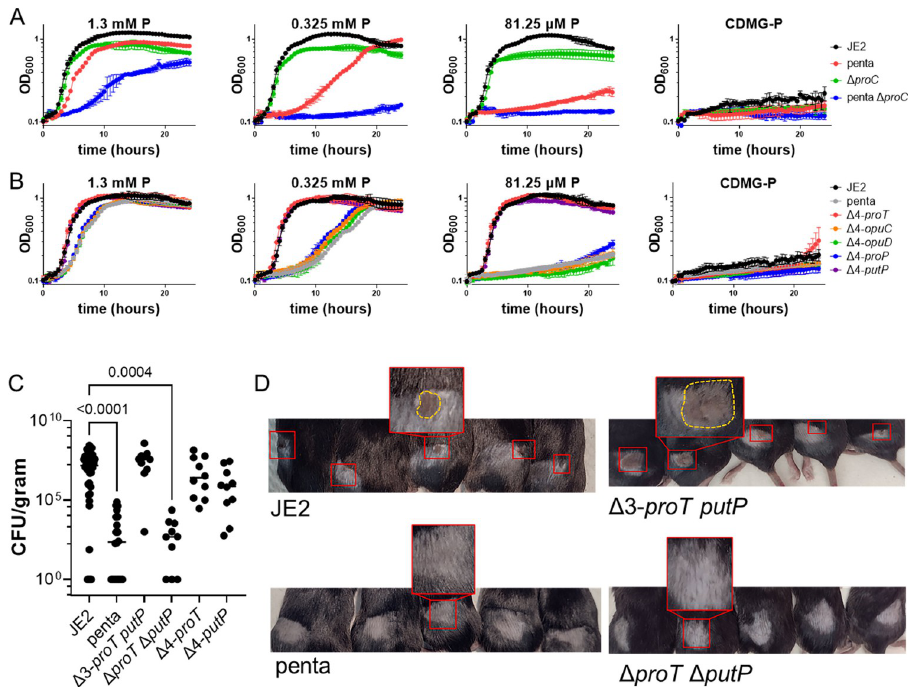
Fig 5. Proline transport supports the establishment of skin and soft tissue infections. A) Growth analysis of JE2, penta, Δ proC , and penta Δ proC in CDMG (3.5 mM glucose) containing 1.3 mM proline (P), CDMG 0.325 mM P, CDMG 81.25 μ M P, or CDMG-P (0 M P). Data are represented by the mean ± SD (n = 3). B) Growth analysis of JE2, penta, Δ 4- proT , Δ 4- opuC , Δ 4- opuD , Δ 4- proP , and Δ 4- putP in CDMG (3.5 mM glucose) 1.3 mM P, CDMG 0.325 mM P, CDMG 81.25 μ M P, or CDMG-P (0 M P). Data are represented by the mean ± SD (n = 3). C) Bacterial burdens of 7-week-old C57BL/6 mice subcutaneously infected with 1x10 6 of S . aureus JE2, penta, Δ 3- proT putP , Δ proT Δ putP , Δ 4- proT , or Δ 4- putP strain 5 days post-infection. Each datum point represents an individual abscess, with the median represented. Statistical significance was determined by Kruskal-Wallis test, with the p value indicated on the graph. D) Representative images of lesions on 7-week-old C57BL/6 mice subcutaneously infected with 1x10 6 of S . aureus JE2, penta, Δ 3- proT putP , or Δ proT Δ putP strain 5 days post-infection. Areas outlined in red indicate the area where the mouse was inoculated in the shaved flank. Enlarged image shows a representation of the disease progression observed in the animal, with yellow highlighting the observed lesion.